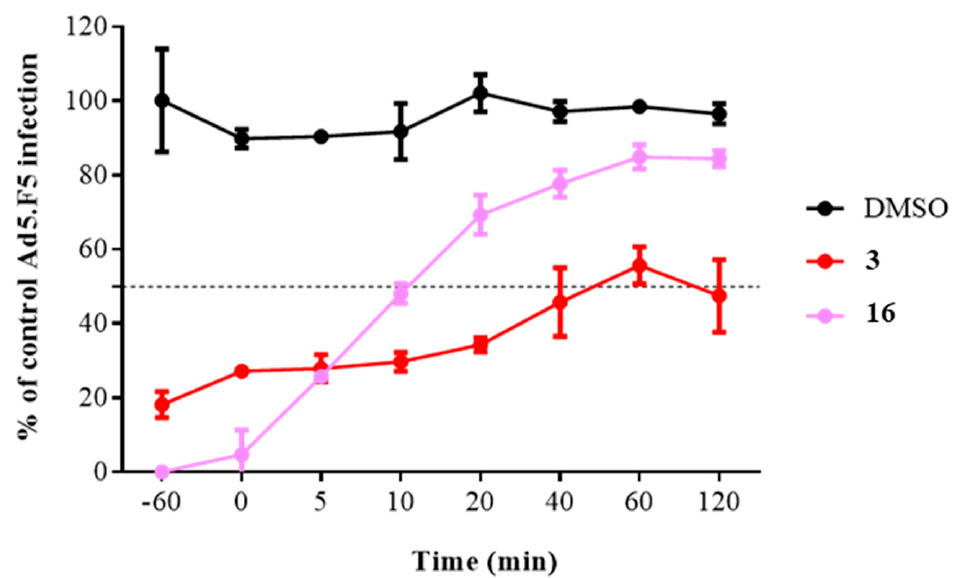
Figure 4. Effect of compound 16 on HAdV infection at different time points. The concentrations used were 5 µ M for niclosamide (3) and 10-fold IC 50 concentration obtained in the plaque assay for analog 16. Line charts represent means ± SD of duplicate samples.